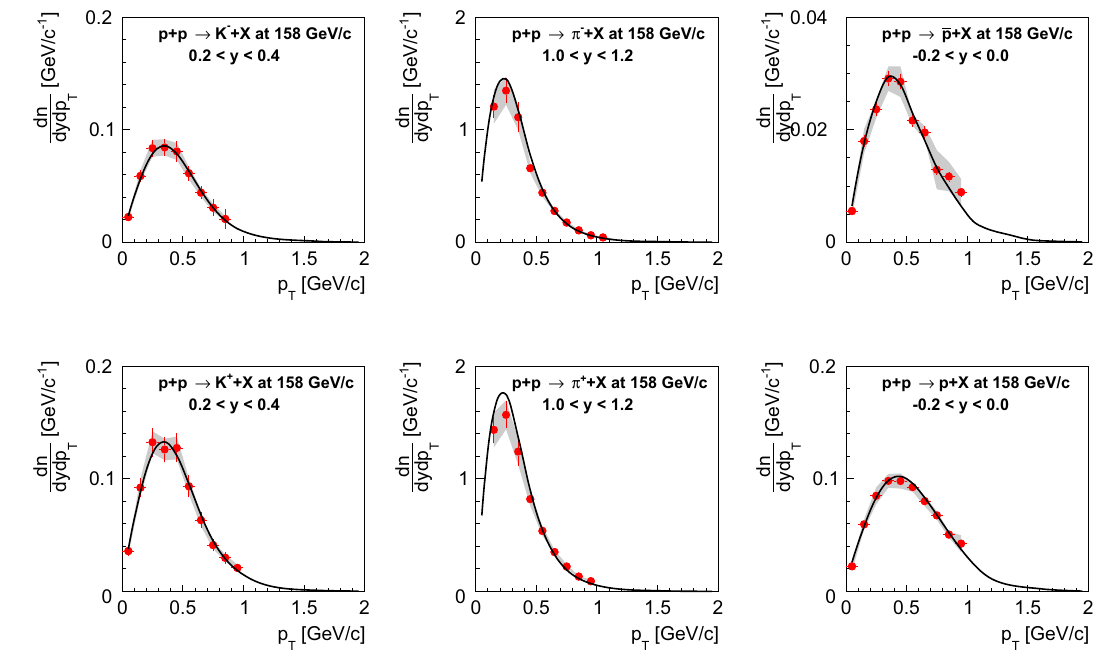
Fig. 24 Transverse momentum spectra of identified hadrons produced in inelastic p + p interactions at 158 GeV / c in selected rapidity intervals in comparison to the EPOS model [21] (black line). Systematic uncertainties are shown as shaded